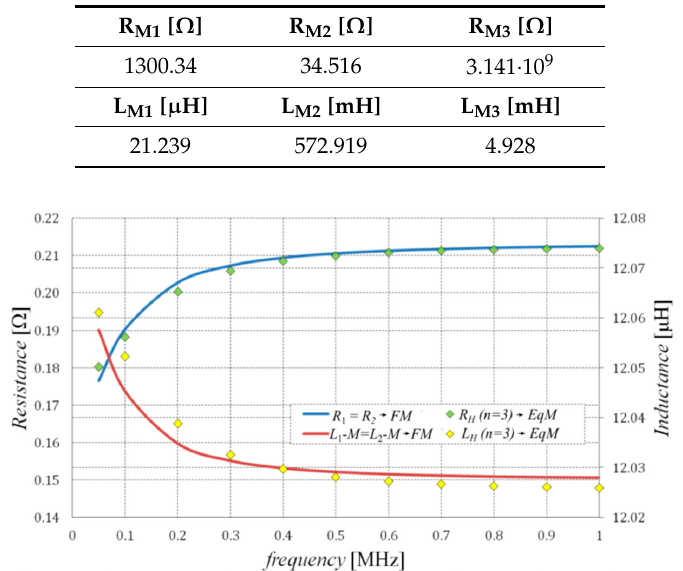
Figure 5. Comparison of the equivalent impedance components obtained for the horizontal branches of the transformer equivalent circuit using the first-order Cauer circuit ( n = 3) and field model.